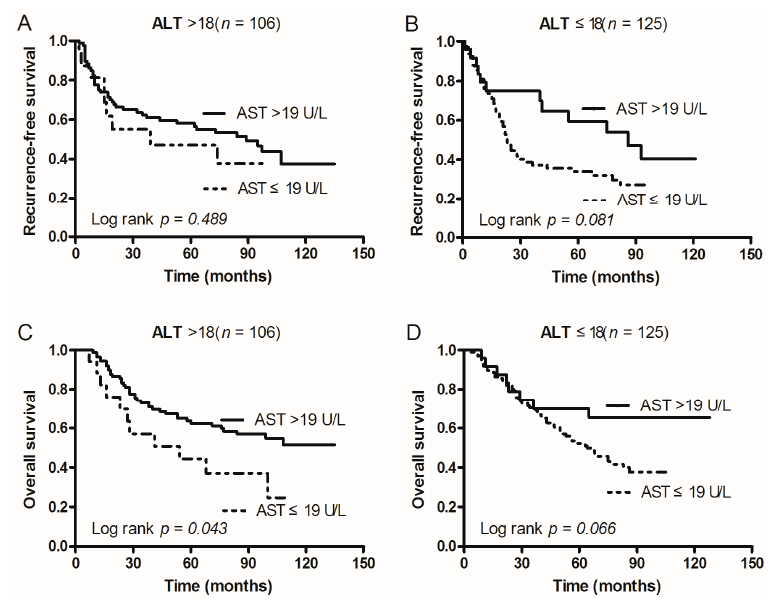
Figure 3. Kaplan–Meier survival curves of patients with AST > 19 U/L and AST ≤ 19 U/L grouped by patient subgroups of ALT. ( A ) In ALT > 18 U/L patients, RFS of patients with AST ≤ 19 U/L was shorter than that of those with AST > 19 U/L ( p = 0.489); ( B ) In ALT ≤ 18 U/L patients, RFS of patients with AST ≤ 19 U/L was shorter than that of those with AST > 19 U/L ( p = 0.081); ( C ) In ALT > 18 U/L patients, OS of patients with AST ≤ 19 U/L was shorter than that of those with AST > 19 U/L ( p = 0.043); ( D ) In ALT ≤ 18 U/L patients, OS of patients with AST ≤ 19 U/L was shorter than that of those with AST > 19 U/L ( p = 0.066).